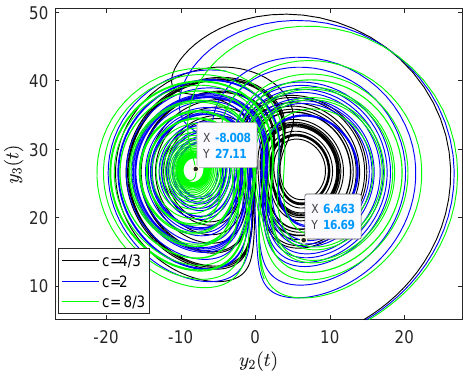
Figure 28. Phase portraits of y 2 and y 3 when varying c .